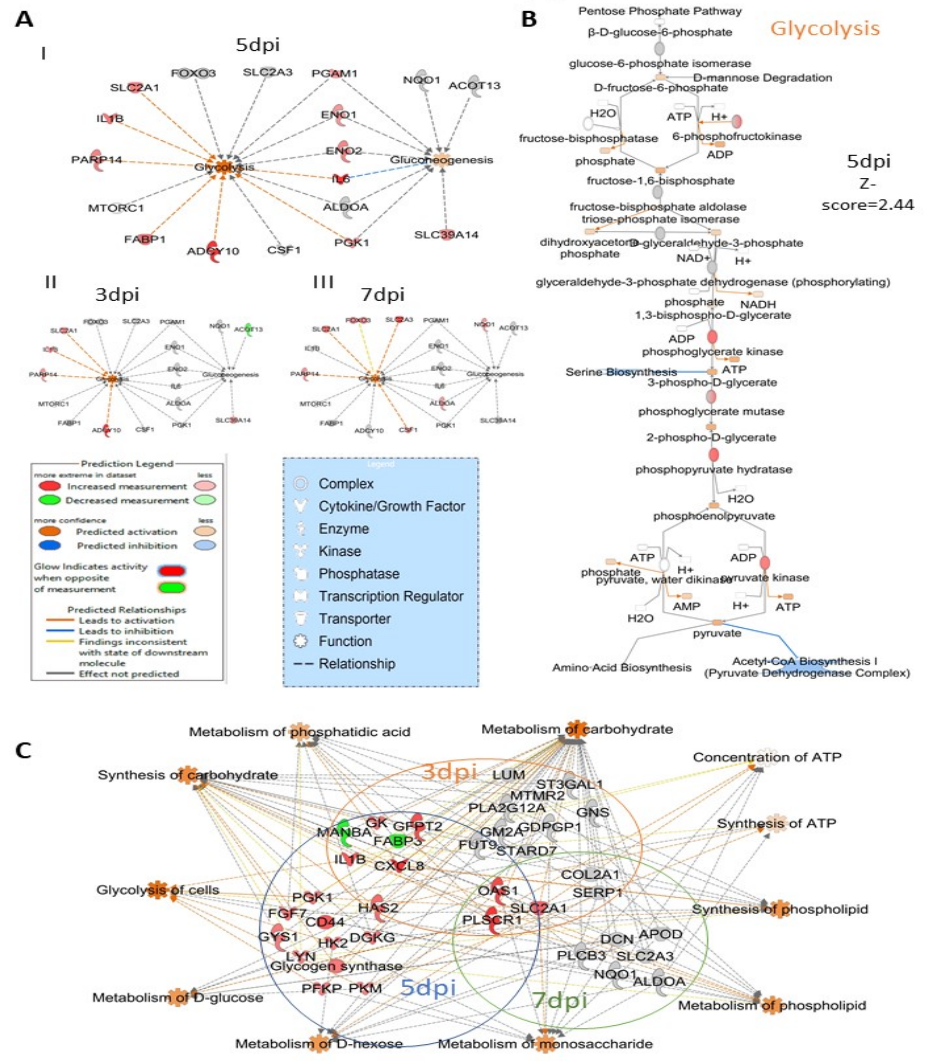
Figure 7. ZIKV infection impacts carbohydrate metabolism in HSerC. ( A ) Proteins and enzymes involved in glycolysis and gluconeogenesis pathways affected by ZIKV infection at I. 5 dpi, II. 3 dpi and III. 7 dpi. IPA predicted the impact of ZIKV infection on ( B ) glycolysis pathway at 5 dpi in Sertoli cells. ( C ) Proteins involved in carbohydrate metabolism and energy production in cells affected by ZIKV infection. Red and green represent up-regulation and down-regulation of protein levels, respectively. Abbreviations. Dpi = Days post infection.